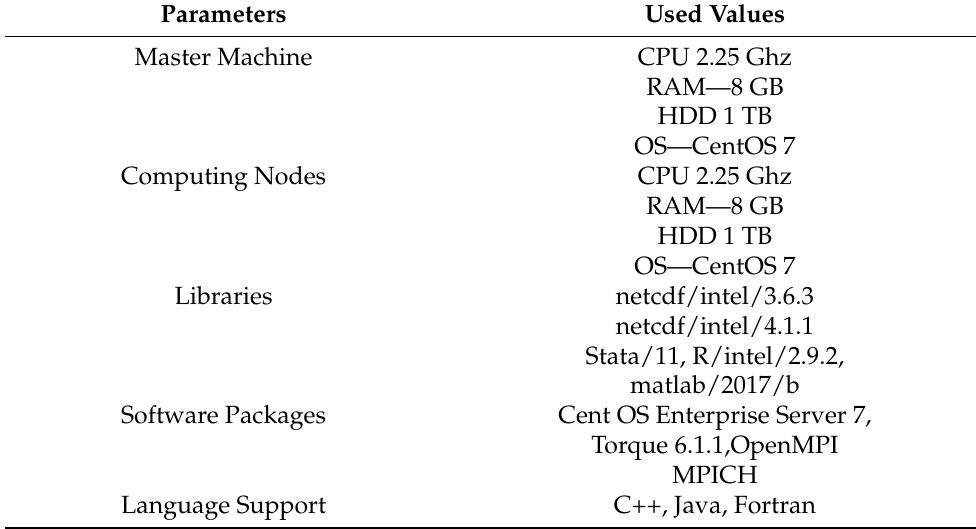
Table 1. DeepStack Cluster Specifications.